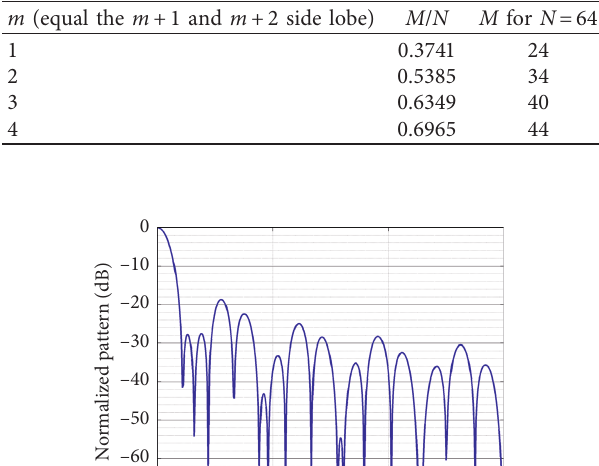
Table 1: Relation between N and M .